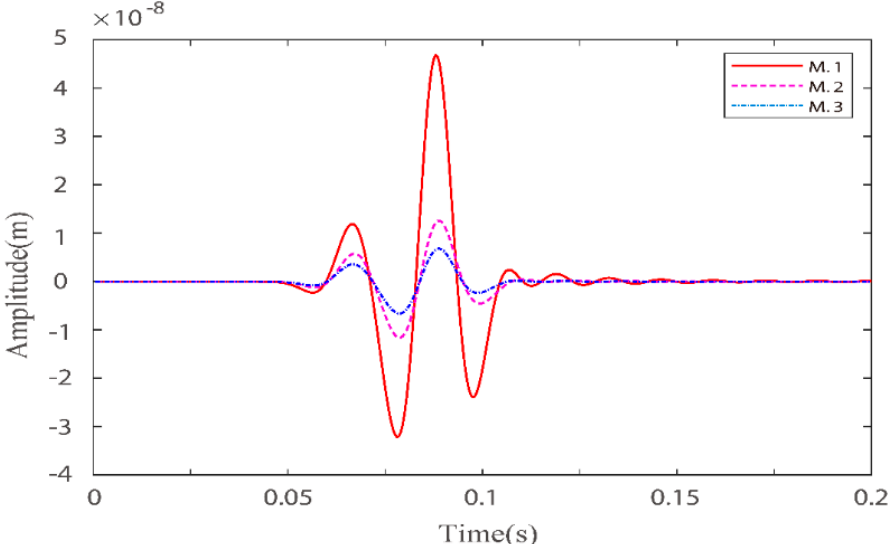
Figure 3. Comparison of solid–phase x–direction velocity components with three different fluid viscosity coefficients at points ( 160,160 ) .